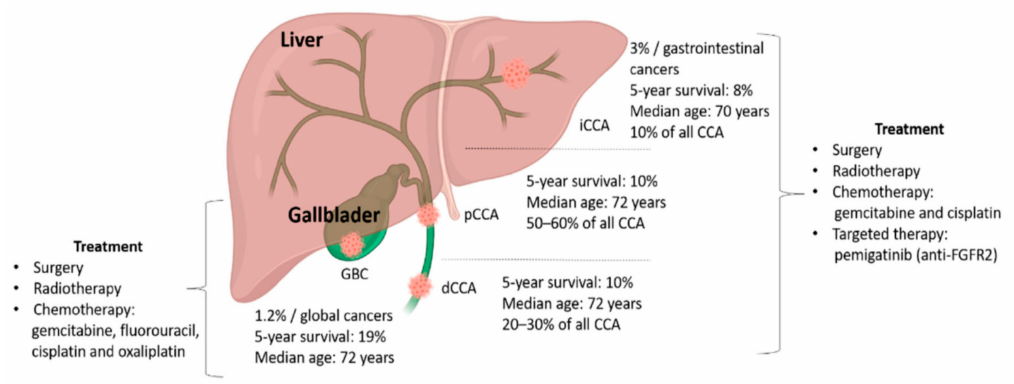
Figure 1. Schematic representation of the anatomic site, demographic information, and treatment options for biliary tract cancers (BTC). Abbreviations: dCCA: Distal cholangiocarcinoma (CCA); GBC: Gallbladder cancer; iCCA: Intrahepatic cholangiocarcinoma; pCCA: Perihilar CCA. From Malenica, I. et al. Cancers (Basel) 2020